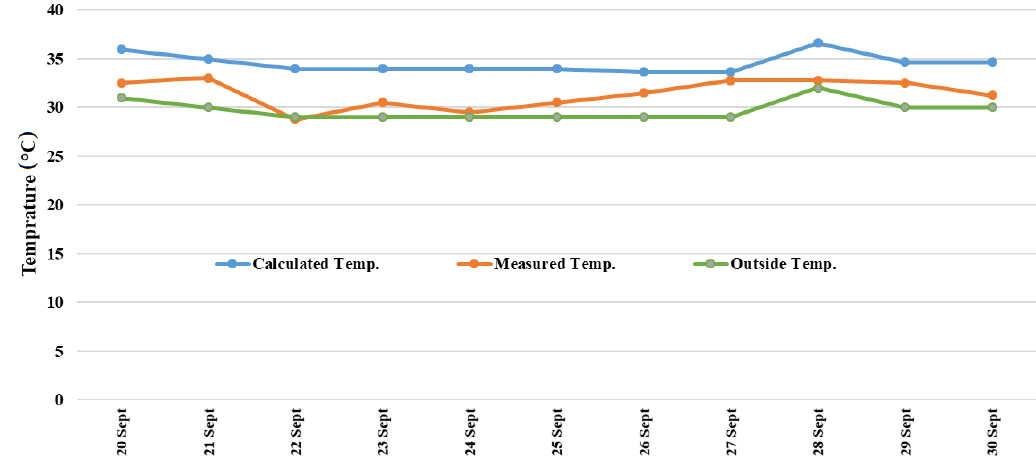
Figure 6. Results obtained by using the mathematical calculation method and the maximum daily measurement values in TR6 after the proposed insulation.